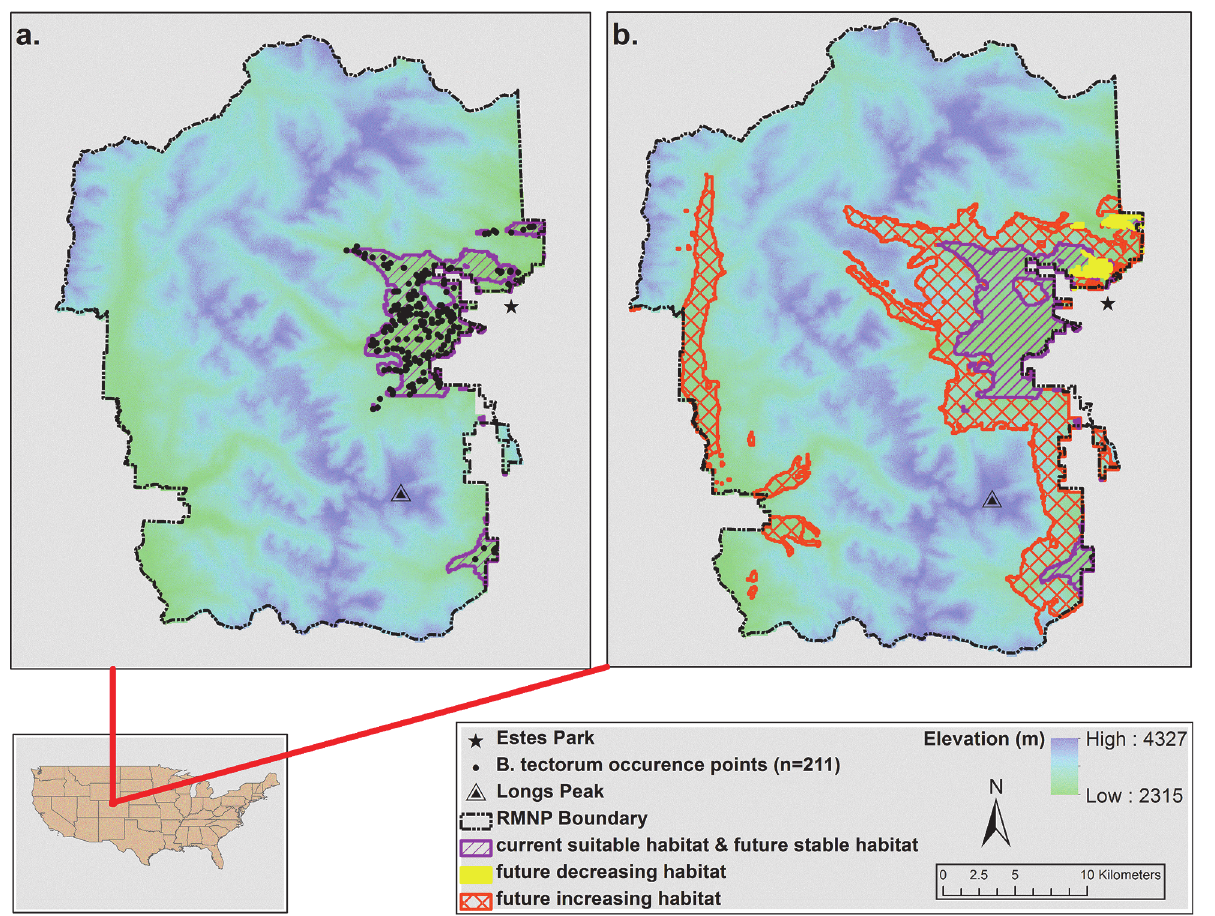
Fig 3. Bromus tectorum current suitable habitat in Rocky Mountain National Park (a) and increasing, decreasing, stable, and unsuitable habitat for the year 2050 (b) based on MaxEnt model outputs. Elevation has been included for reference (coordinate system NAD 1983 UTM Zone 13